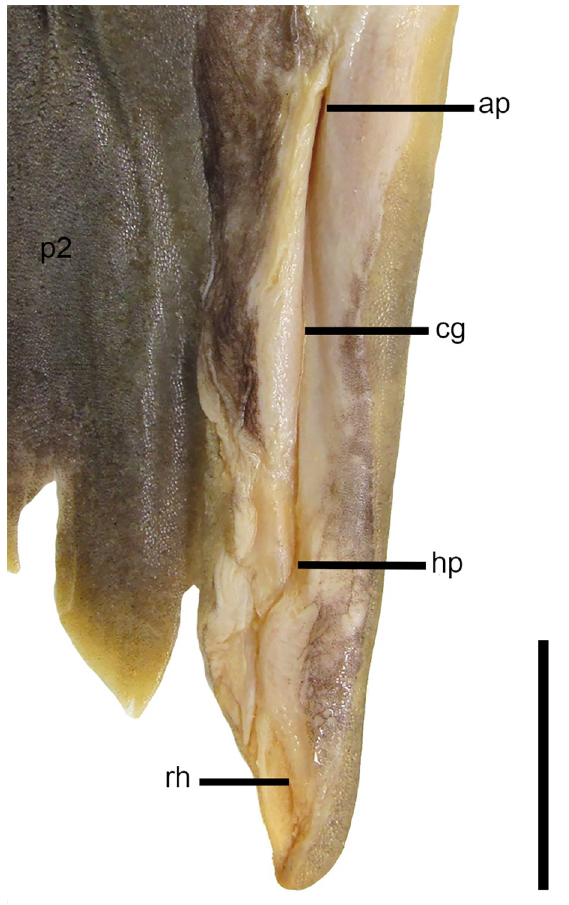
Fig 31. Clasper (left side) of C . australis , NMNZ P 38074, adult male, 1020 mm TL in dorsal view. Abbreviations: ap: apopyle; cg: clasper groove; hp: hypopyle; p2: pelvic fin; rh: rhipidion. Scale bar: 20